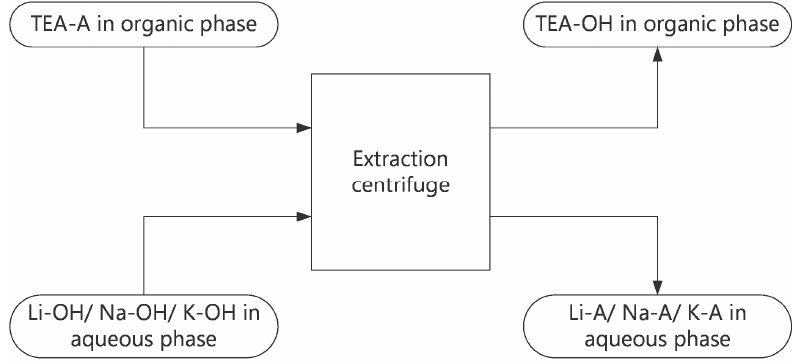
Figure 4. Simplified process scheme of application 1.